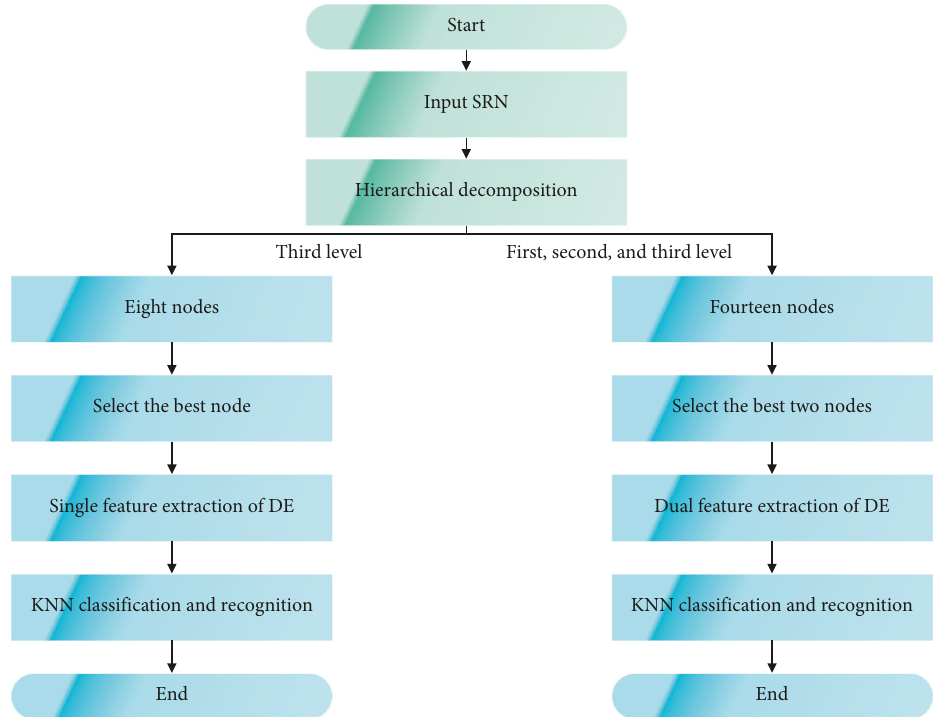
Figure 1: The method of identifying SRN using HDE